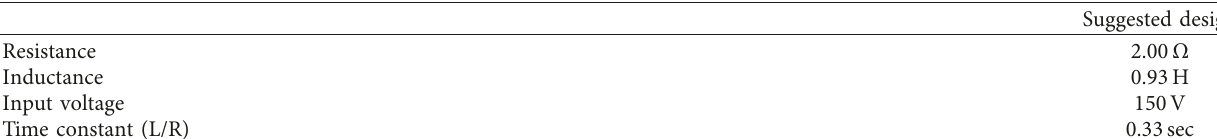
Figure 10: FE analysis of electromagnetic actuator for electromagnetic field by Maxwell. (a) Analysis model. (b) Analysis results of ANSYS Maxwell. Table 7: Major parameters of suggested electromagnetic actuator.